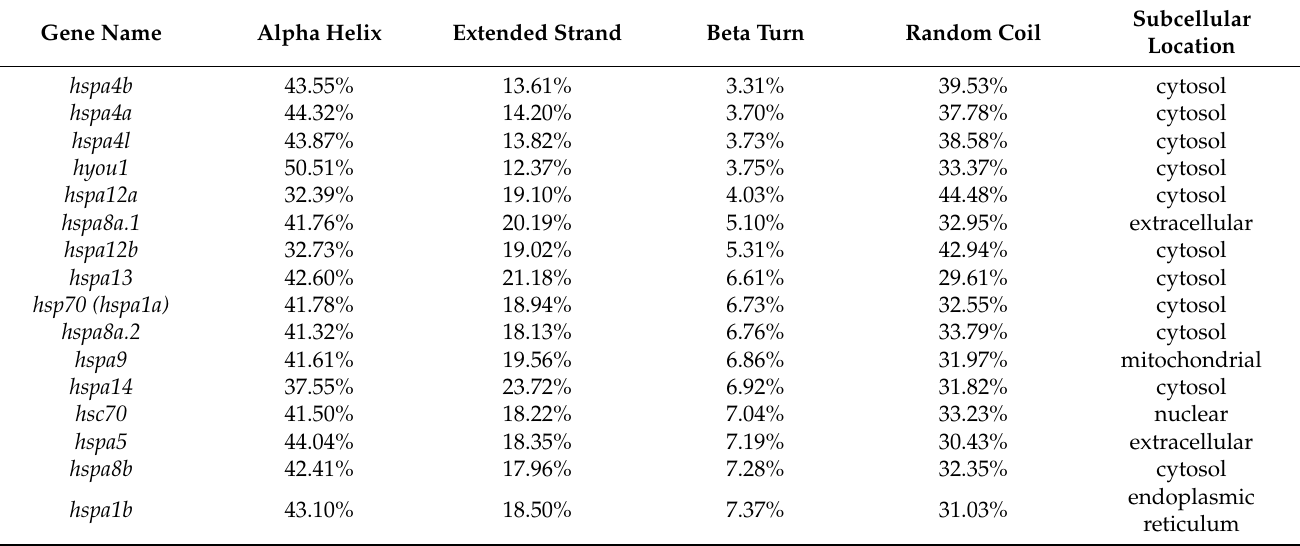
Table 3. The secondary structure prediction and subcellular location prediction of HSP70 proteins in S. maximus